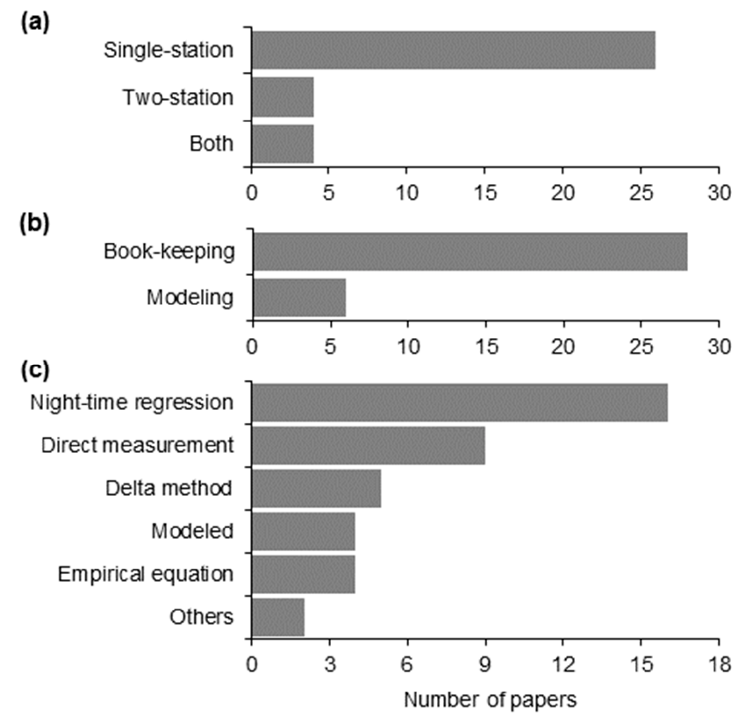
Figure 10. Procedures used in field studies using the open-channel method ( n = 34) ( a ) to obtain the field data of DO, ( b ) to compute metabolic parameters, and ( c ) to estimate the reaeration rates.